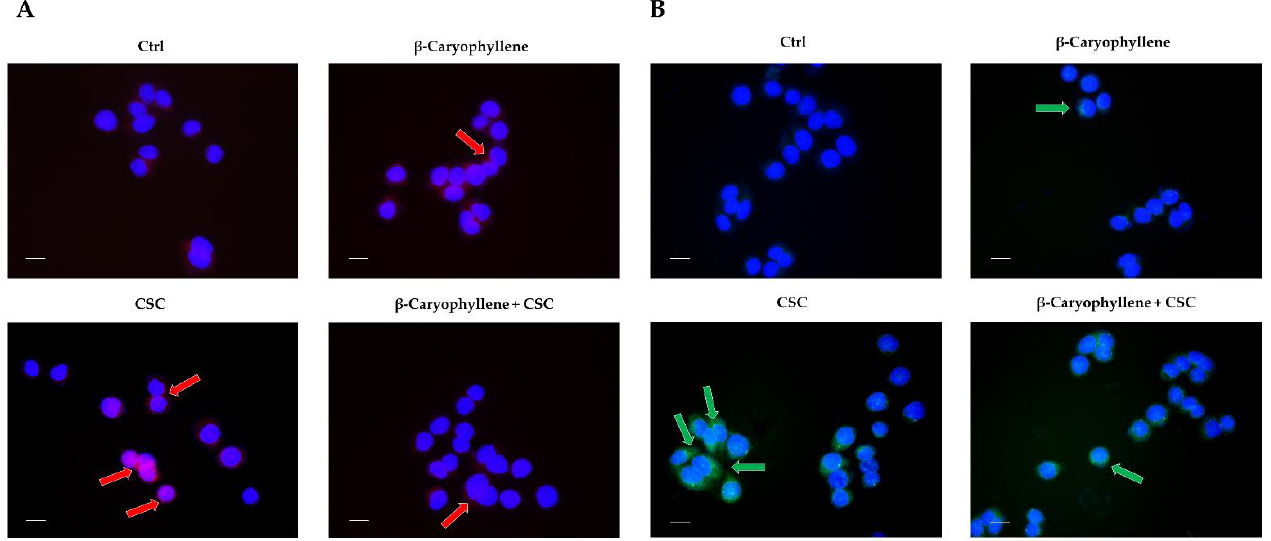
Figure 13. Immunofluorescence analysis of Beclin-1 and LC3 II expression induced by β -caryophyllene and cigarette smoke condensate (CSC) in MDA-MB-468 cancer cells after 24 h exposure. ( A ) Representative images of cells stained by a primary anti-Beclin 1 antibody, nucleic acid DAPI dye and secondary red fluorescent antibody. ( B ) Representative images of cells stained by a primary anti-LC3 II antibody, nucleic acid DAPI dye and secondary green fluorescent antibody. Data are displayed as mean ± SE of at least three independent experiments with at least three technical replicates ( n = 9). Scale bars = 20 μm.